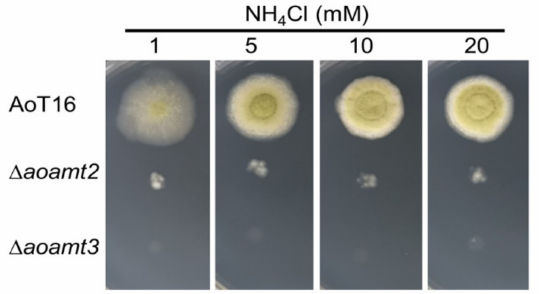
Figure 5. Radial growth analysis of the aoamt -disrupted strains of A. oryzae . Five µ L aliquots of spore suspension (5000 spores) of the ∆ aoamt2 and ∆ aoamt3 strains were spotted on mCD medium (pH 4.5) containing 1, 5, 10, or 20 mM NH 4 Cl. The recipient (AoT16) was used as a control. Fungal cultures were incubated at 30 ◦ C for three days.